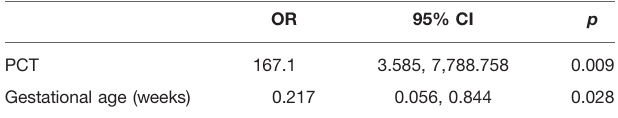
TABLE 3 | Multivariate logistic regression for implementing surgical treatment in NEC patients.